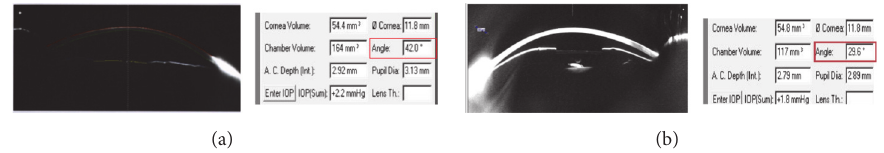
Figure 7: AC angle before (a) and after (b) ICL implantation in patient number